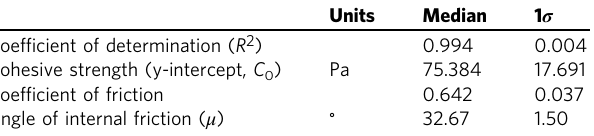
Table 2 Sand material